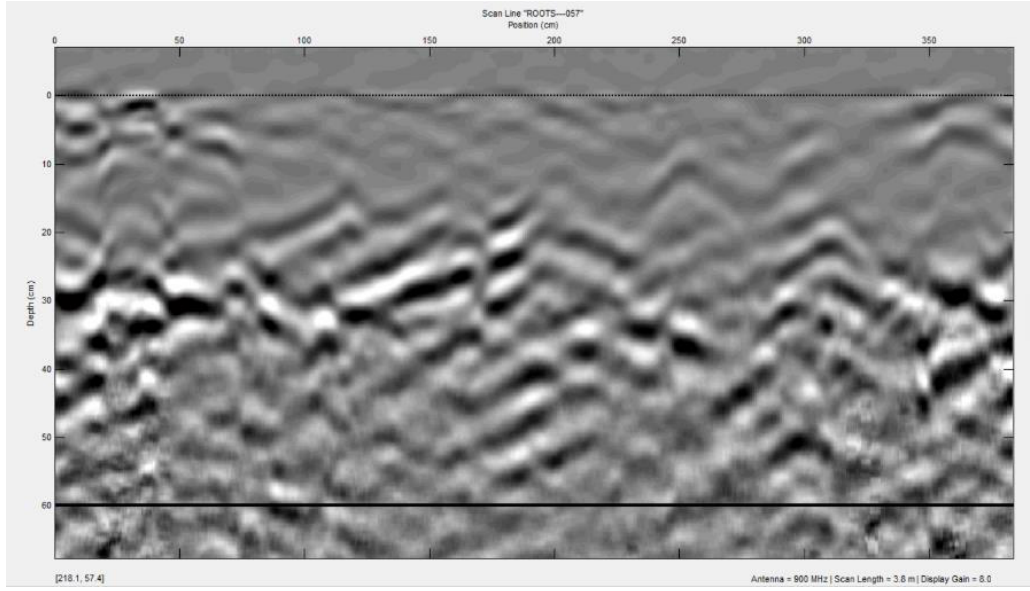
Figure 2. B-scan hyperbola image.